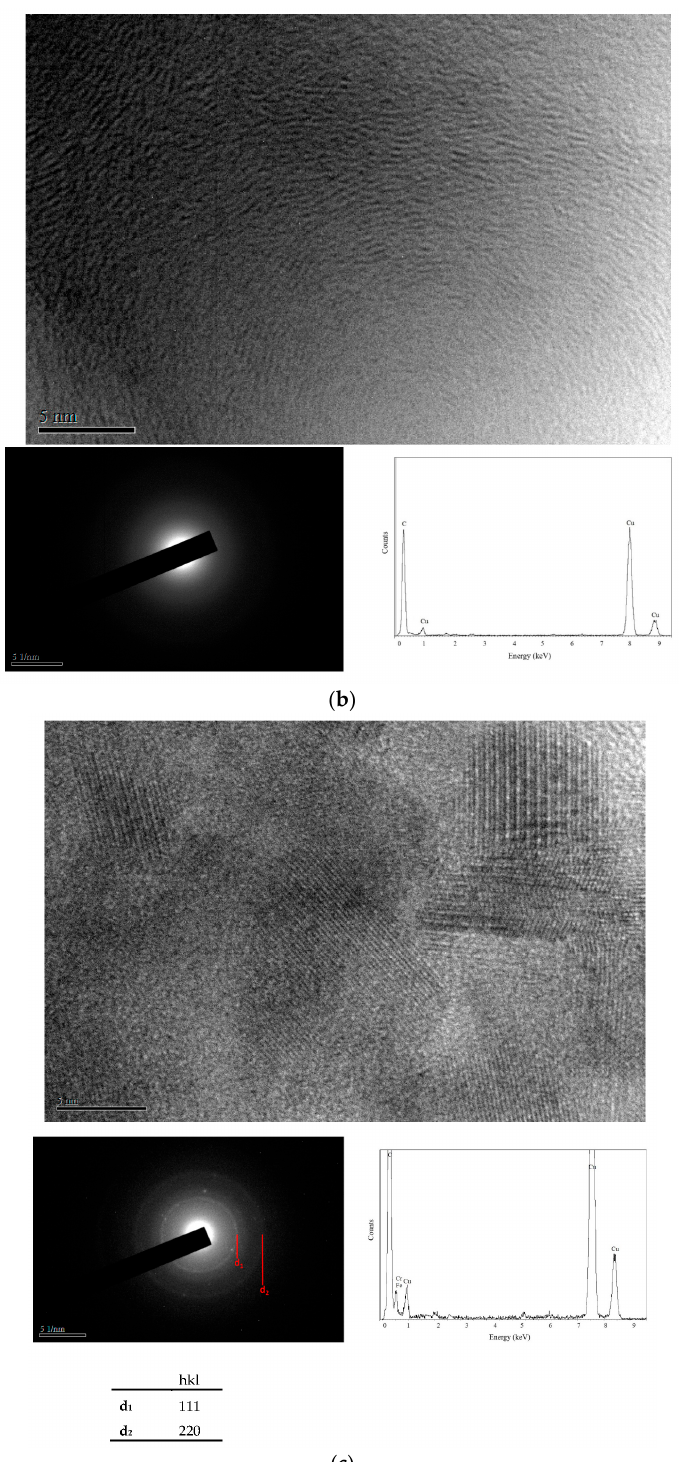
Figure 6. ( a ) Lattice image of the extracted hardening phase in the anneal-hardened Fe-Cr-C alloy deposit prepared with 20 ASD. The deposit was RTA-treated at 500 ◦ C for 10 s. The diffracted plane of d 1 and d 2 are corresponding to (111) and (220) planes of the diamond structure; ( b ) Lattice image of the extracted hardening phase in the anneal-hardened Cr-Fe-C alloy deposit prepared with 25 ASD, showing an amorphous structure. The deposit was RTA-treated at 500 ◦ C for 10 s; ( c ) Lattice image of the extracted hardening phase in the anneal-hardened Cr-Fe-C alloy deposits prepared with 30 ASD. The deposit was RTA-treated at 500 ◦ C for 10 s. The diffracted plane of d 1 and d 2 are corresponding to (111) and (220) planes of the diamond